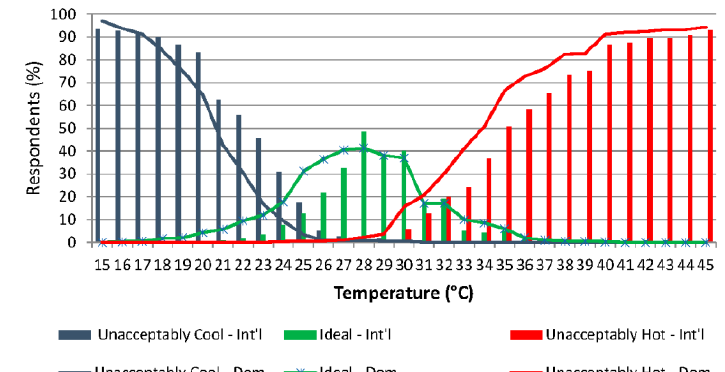
Figure 1. Unacceptably cool (blue), ideal (green), and unacceptably hot (red) temperatures for Canadian beach tourists traveling internationally (stacked bar) and domestically (line).